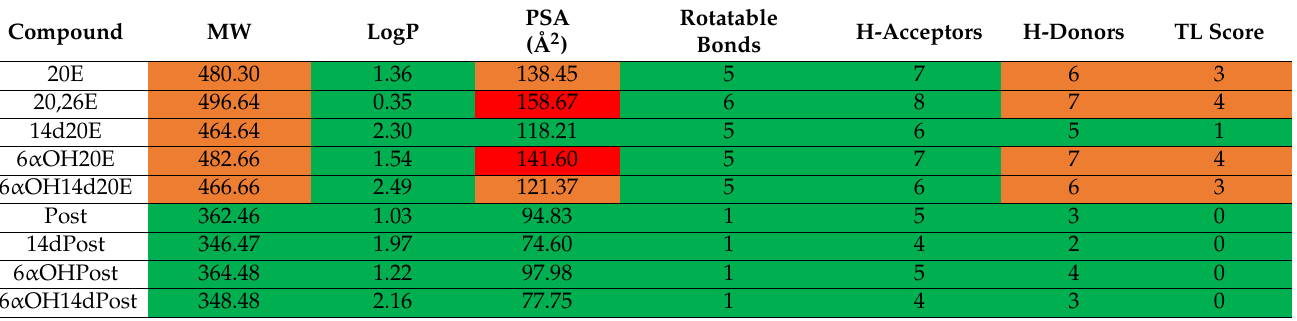
Table 6. Drugability scores for